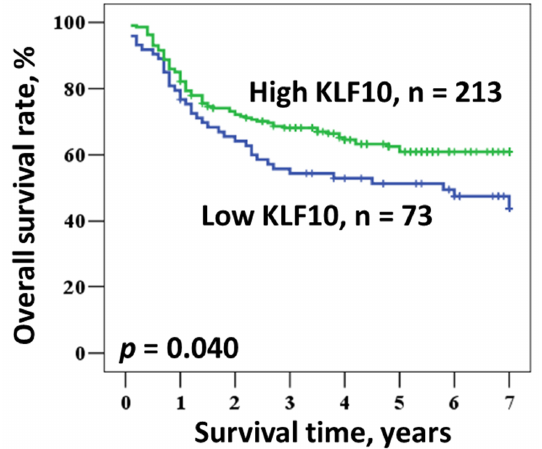
Figure 2. Kaplan–Meier survival of OSCC patients according to KLF10 expression.